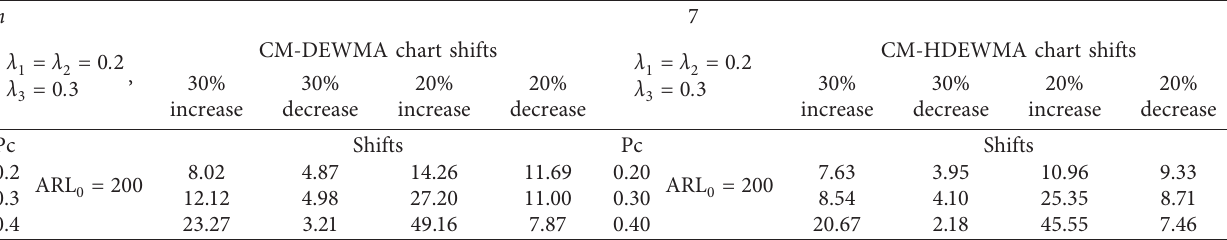
Table 11: Out-of-control ARL values for CM-HDEWMA and CM-DEWMA control charts for n � 3 with α � 0 . 5 , β � 0 . 5 for λ n 3 � 0 . 1 λ 1 � 0 . 15 λ 2 0.2